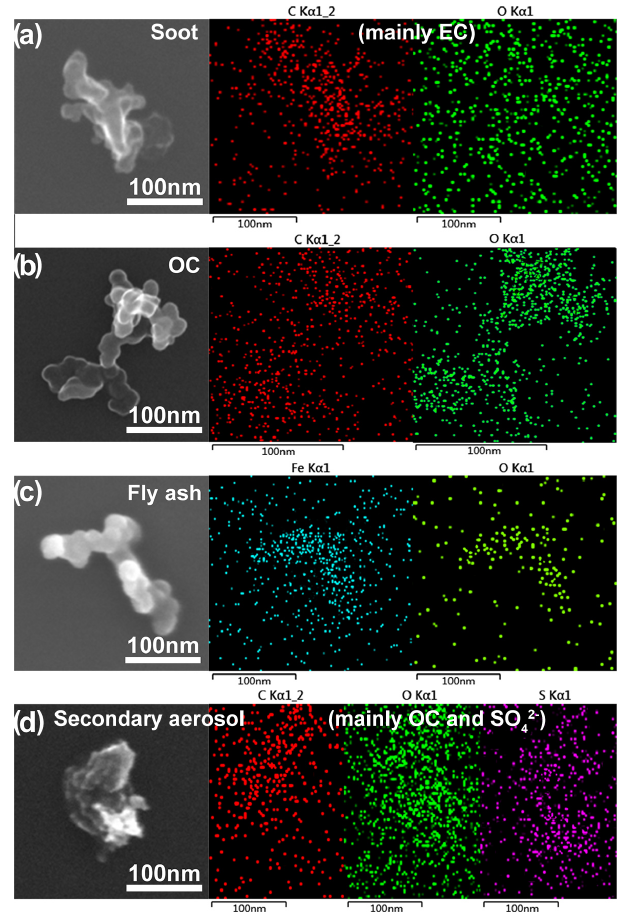
Figure 4. SEM and EDS mapping of typical 100nm atmospheric particles collected i on 28 September